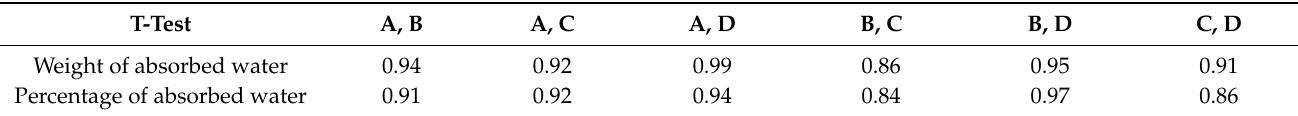
Table A7. T-test results of water absorption